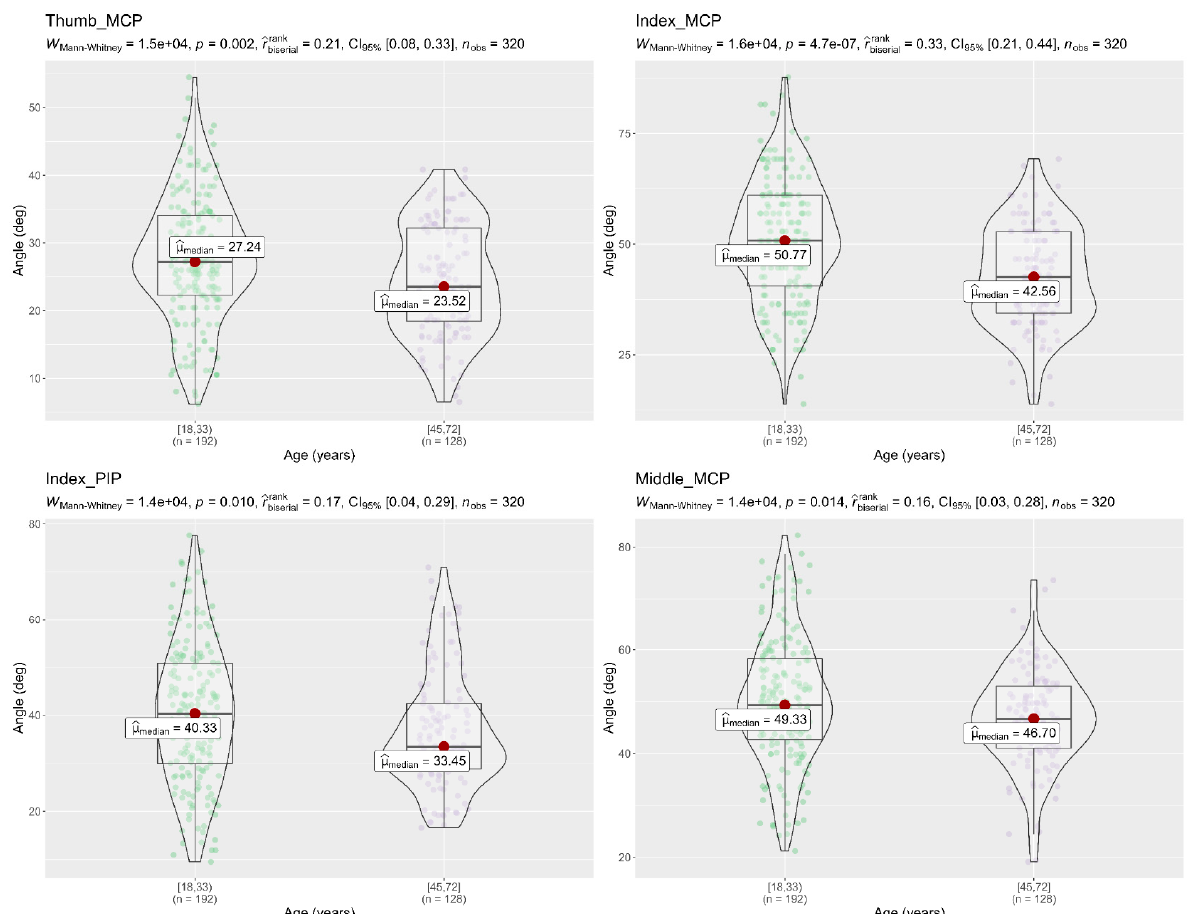
Figure 8. Mann–Whitney U test flexion angle of the finger joints with respect to different age groups.